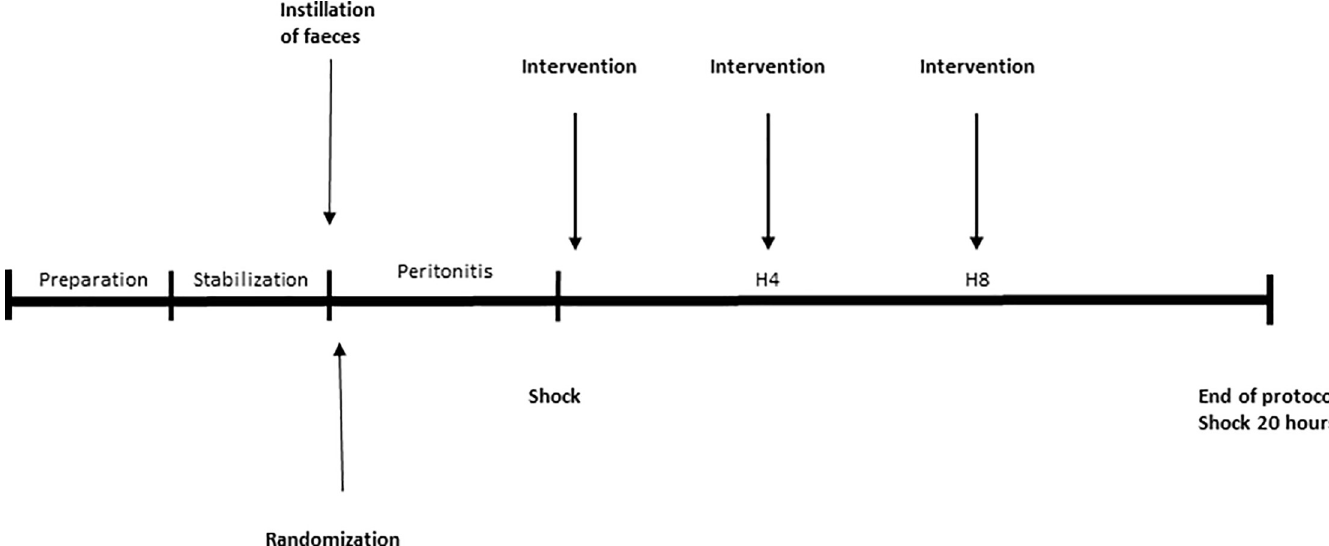
Fig 1. Experimental time line. After preparation and stabilization we induced peritonitis by instillation of autologous feces and the animals were randomized to intervention or control group in a blind manner. Untreated peritonitis preceded the onset of circulatory instability, when a protocolized resuscitation was initiated and intervention (or saline alone) was given at time points 0-, 4- and 8-hours. Piperacillin/Tazobactam 2 grams in 10 ml of 0.9% saline was given every 8 hours i.v. The total observation period for each animal after onset of circulatory instability was twenty hours or until death.